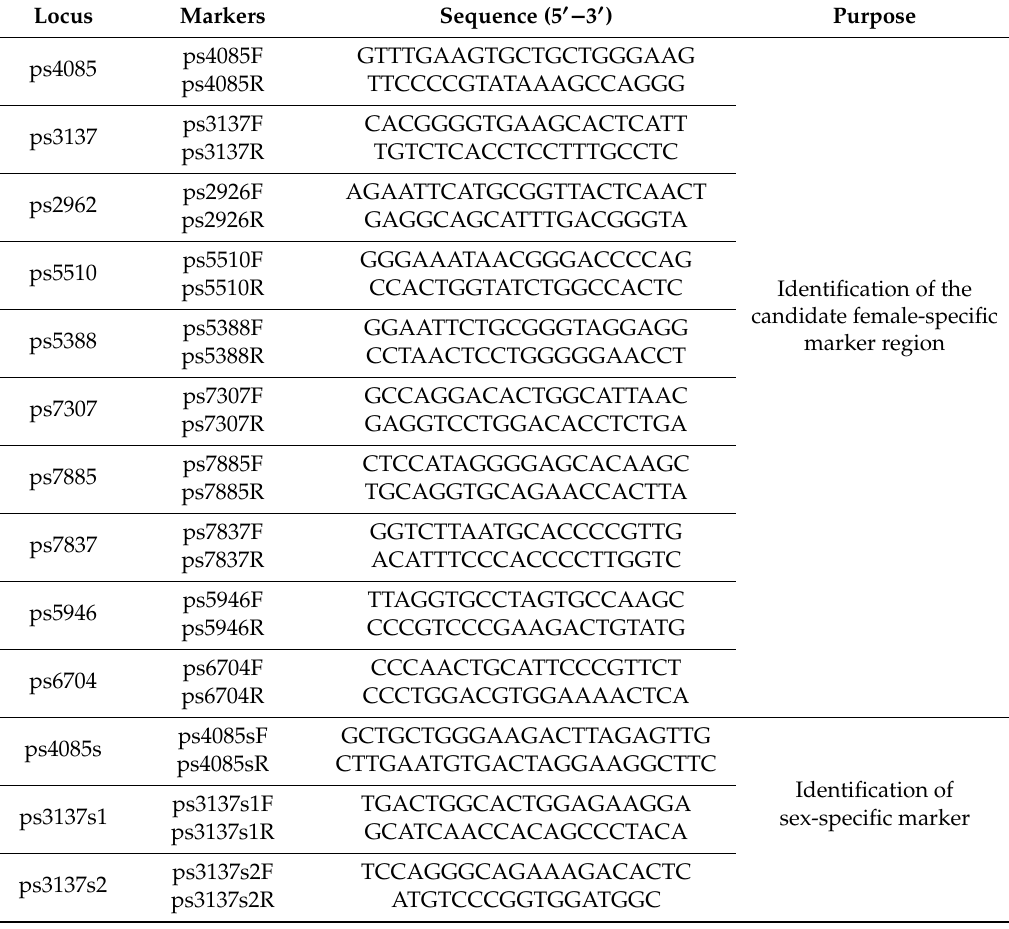
Table 1. Candidate sex-specific markers used in female Chinese soft-shelled turtles. Locus Markers Sequence (5 (cid:48) − 3 (cid:48) ) Purpose ps4085F GTTTGAAGTGCTGCTGGGAAG ps4085